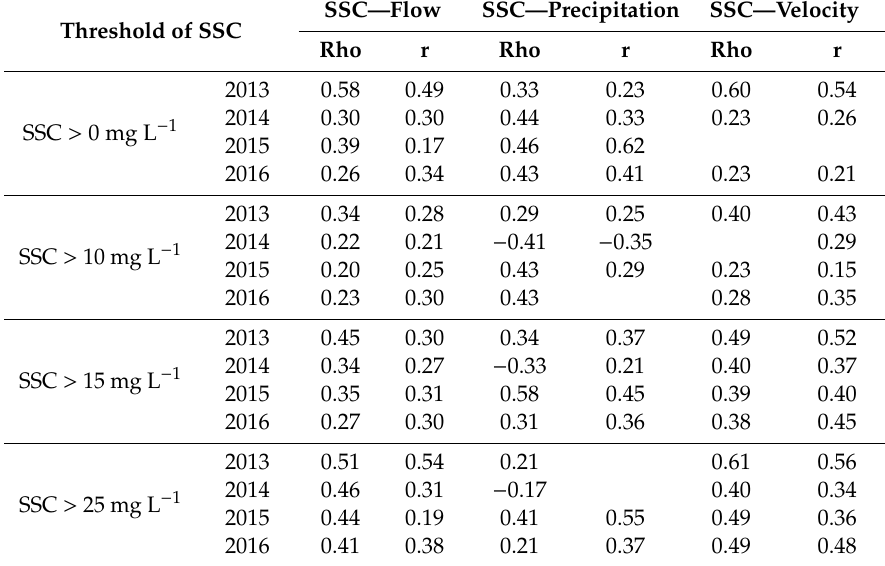
Table 2. Significant correlation ( p < 0.05%) for Spearman (Rho) and Pearson (r).